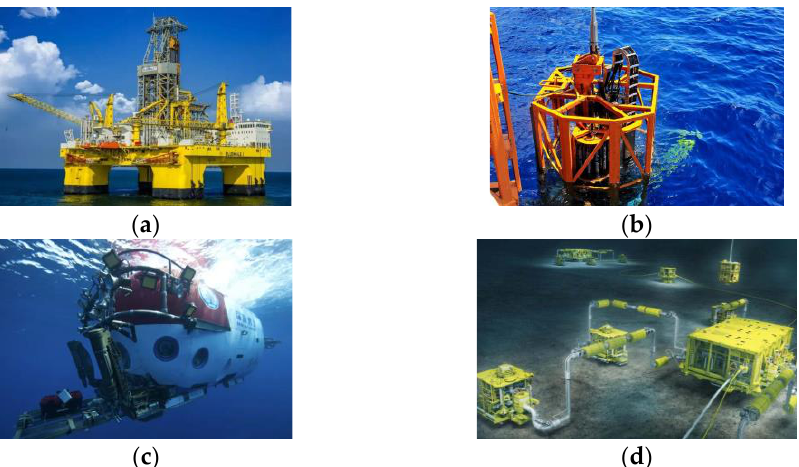
Figure 1. Applications of hydraulic piston pumps. ( a ) Offshore drilling platform, ( b ) deep-sea drill, ( c ) deep-sea manned submersible, ( d ) deep-sea oil and gas exploitation.